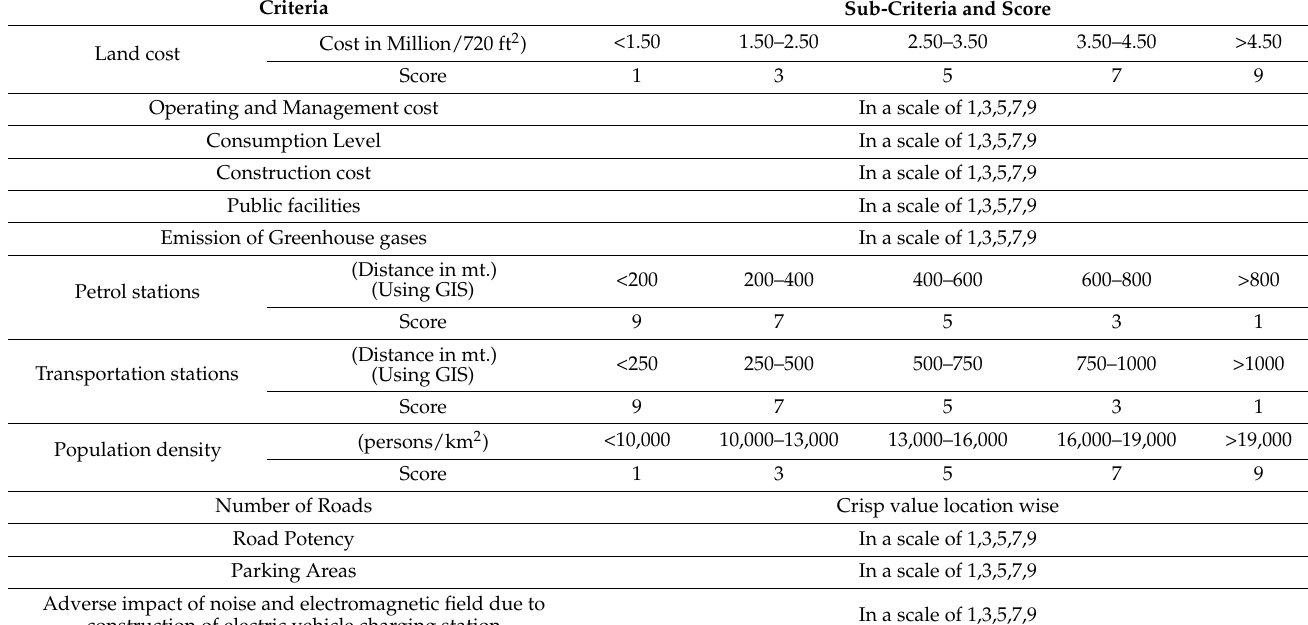
Table 3. Sub-factors taken for the study.